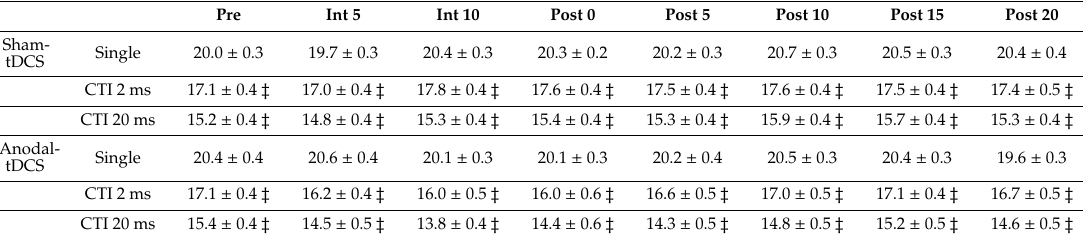
Table 2. H-reflex amplitude (%